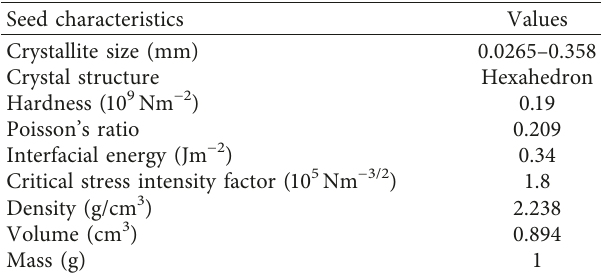
Table 1: Characteristics of sodium chloride seed crystals.